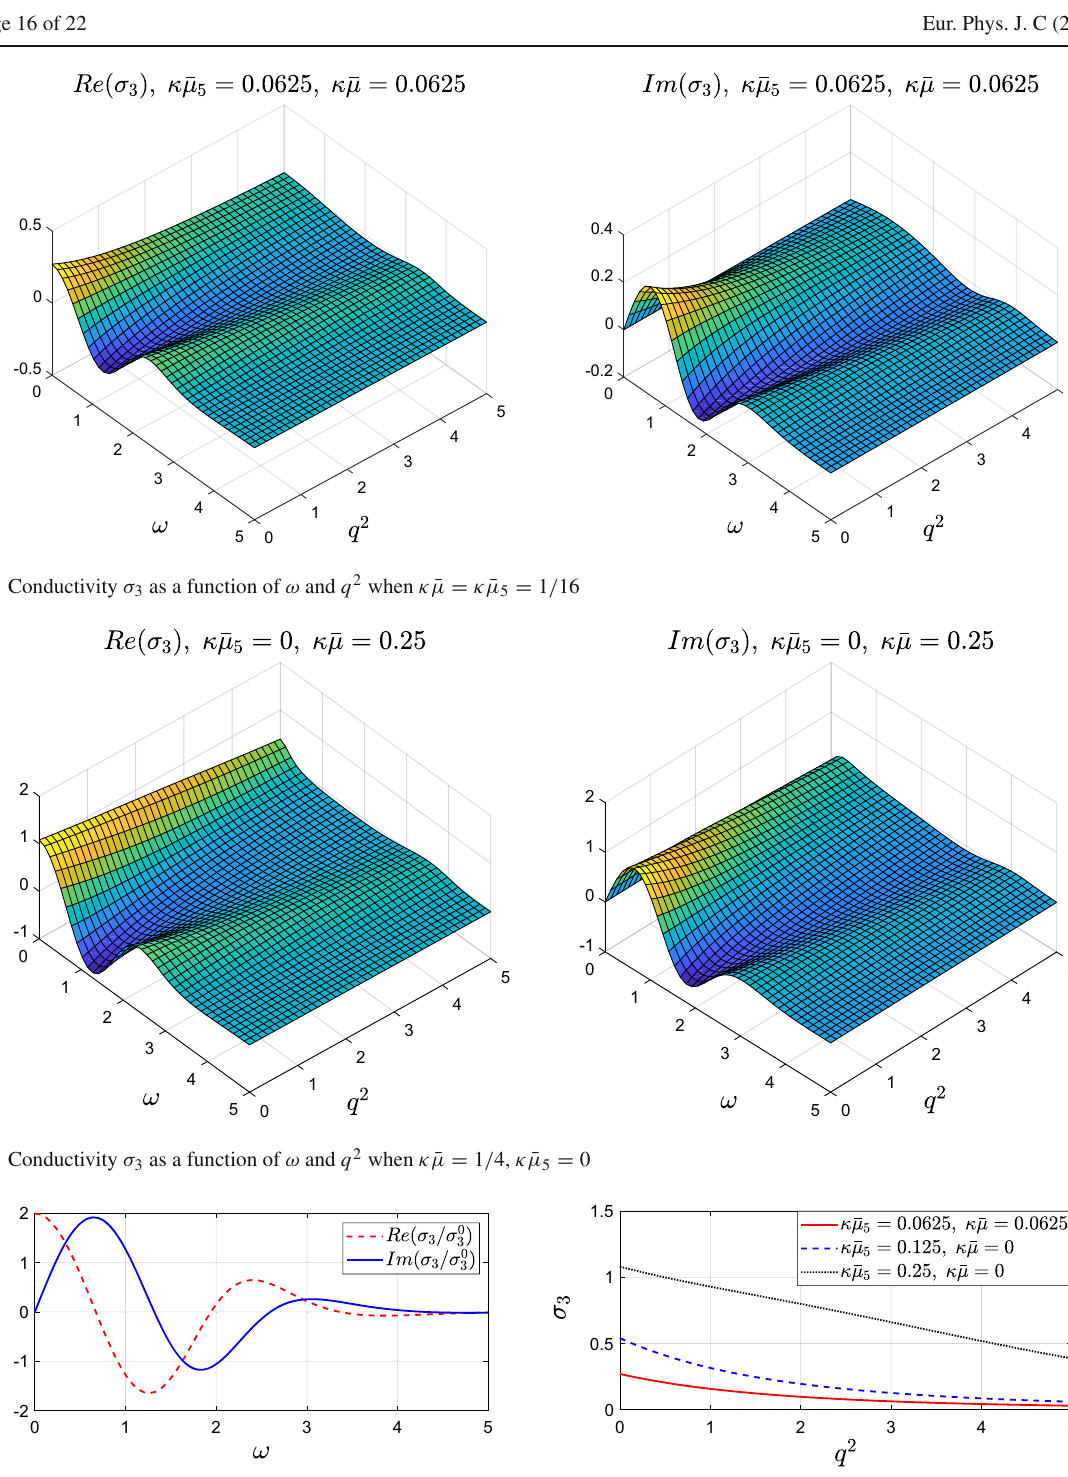
Fig. 20 ω -dependence of σ 3 /σ 0